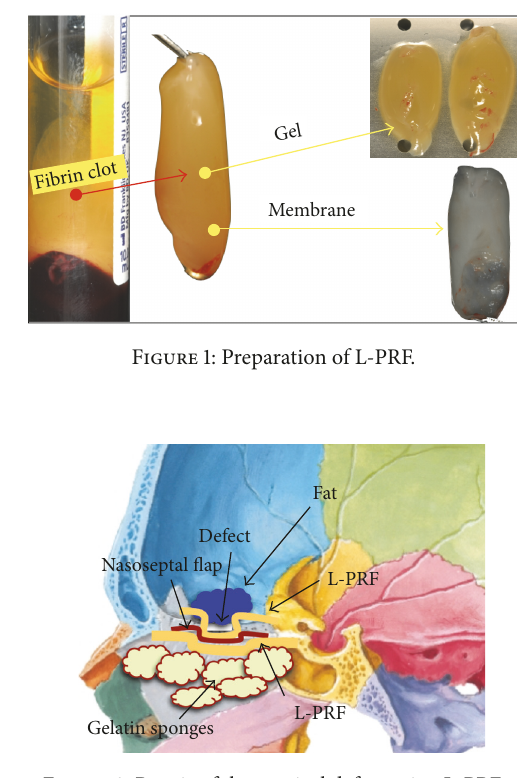
Figure 2: Repair of the surgical defect using